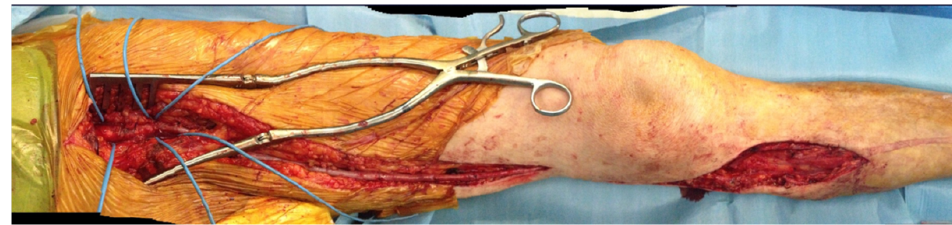
Figure 2. Final outcome of autologous inverted saphenous femoro-popliteal BTK bypass.